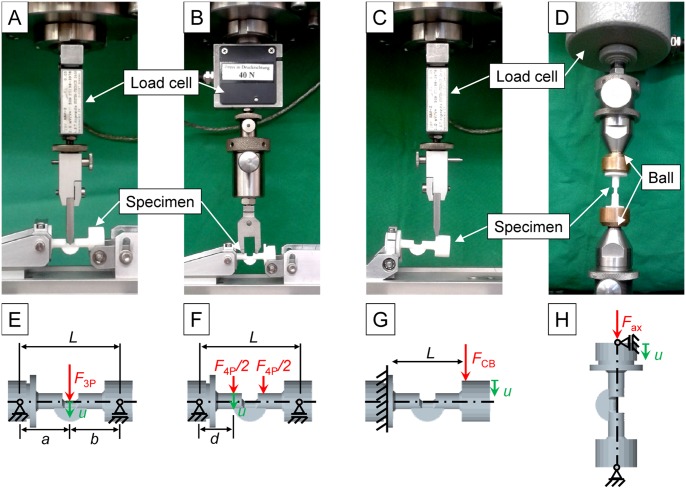
Test setups and boundary conditions for four different experiments: A) and E) three-point bending, B) and F) four-point bending, C) and G) cantilever bending, D) and H) axial compression.